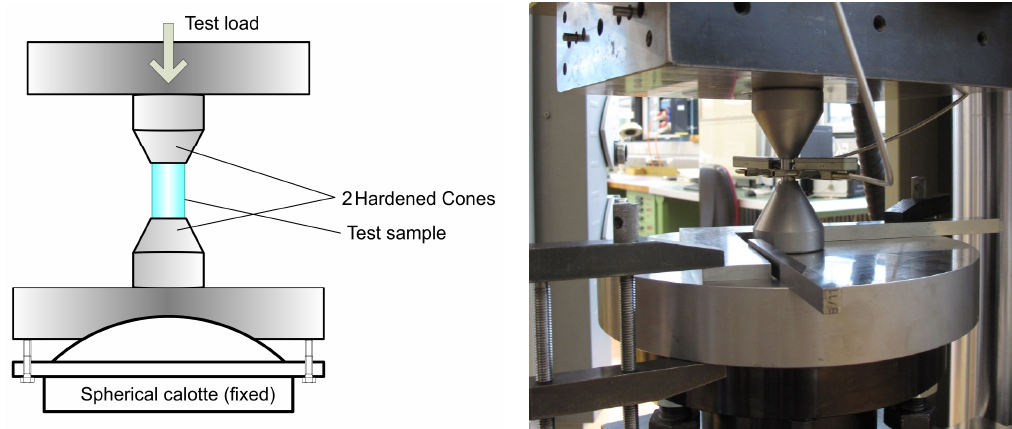
Figure 1. Schematic view of the mechanical setup ( left ) and installation with prepared sample in the test machine ( right ), with large plates adjusted and fixed in parallel.